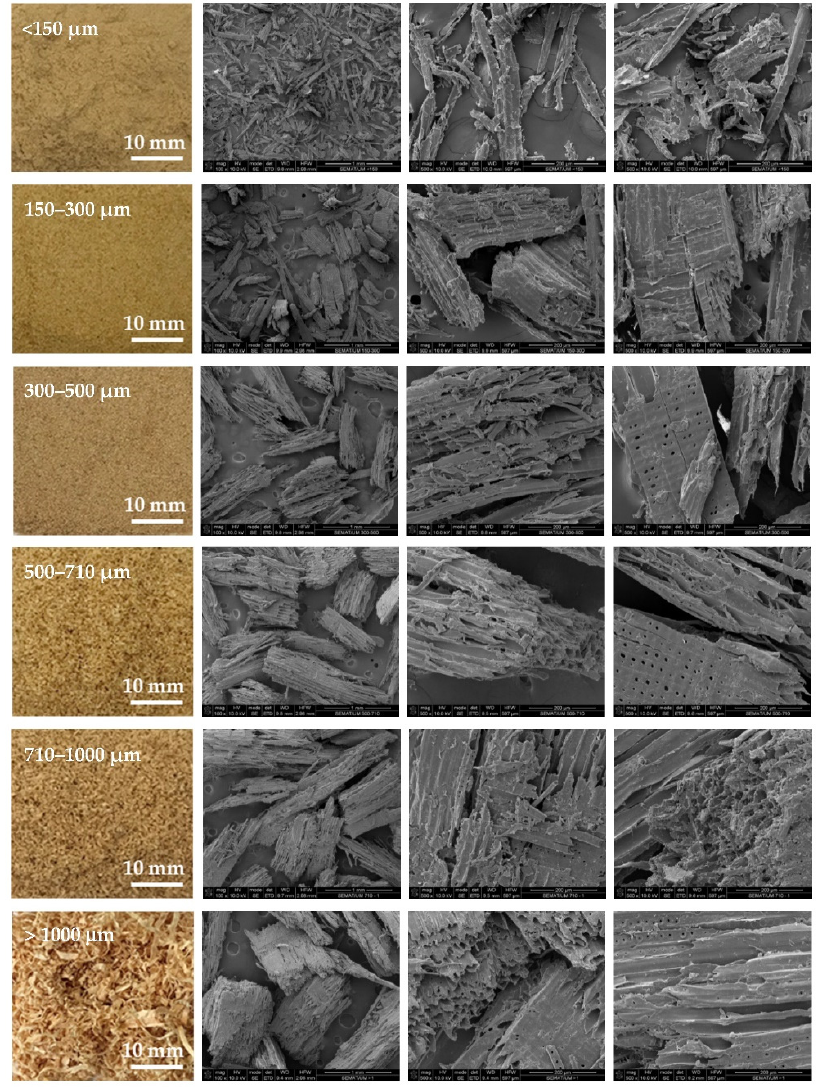
Figure 3. Images of wood sawdust according to its granulometry.